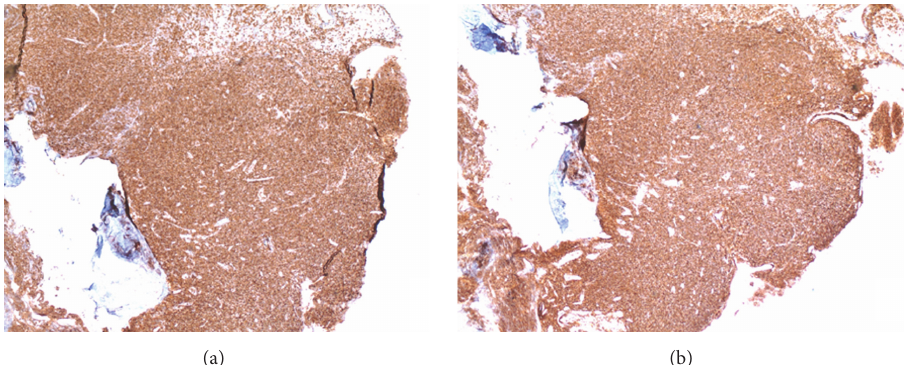
Figure 1: Immunohistochemical staining demonstrating a monomorphic population of CD20 positive lymphocytes with coexpression of CD5 typical of CLL.